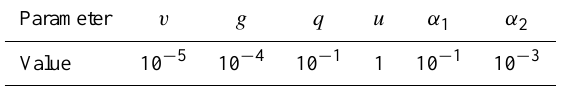
Table 4. Parameters of noise estimations for the lidar system.